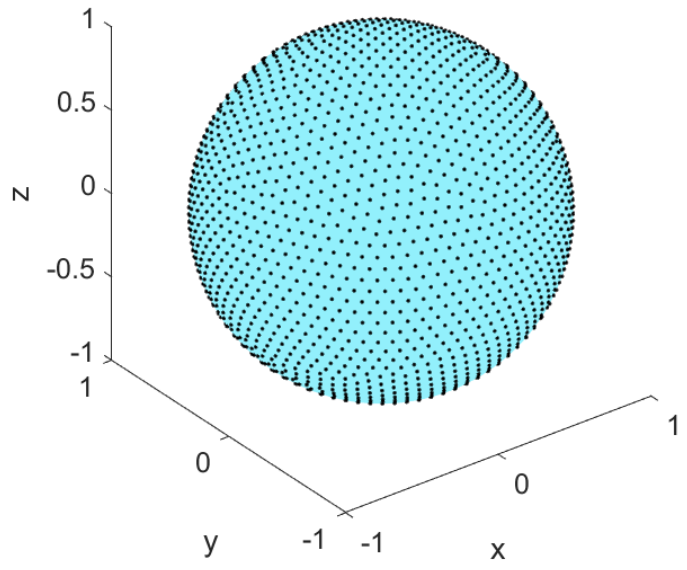
Figure 1. Sketch of the quasi-uniform points distributed on the unit sphere: the point sets could be obtained by using the minimum energy (ME) algorithm